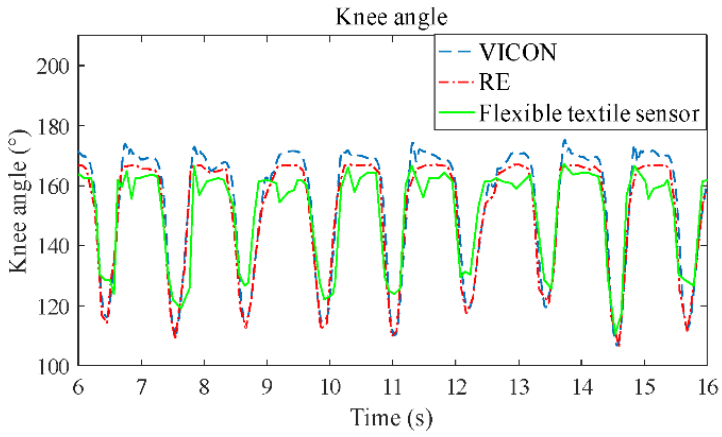
Figure 5. The comparison of angle measurement with the electrogoniometer (RE) and VICON systems, and the flexible textile sensor.